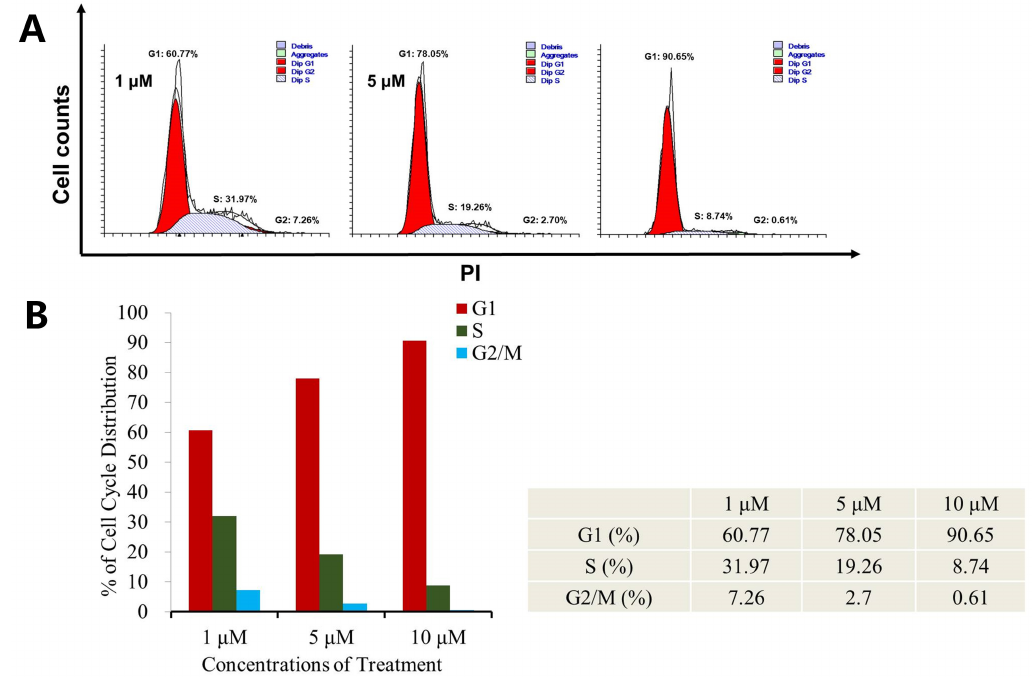
Figure 7. E ff ects of compound 7i on A549 cell cycle progress for 24 h. ( A ) Treatment of A549 cells with compound 7i at di ff erent concentrations (1 µ M, 5 µ M, 10 µ M) for 24 h. ( B ) Quantitative analysis of cell cycle. The experiments were performed three times, and a representative experiment is shown.